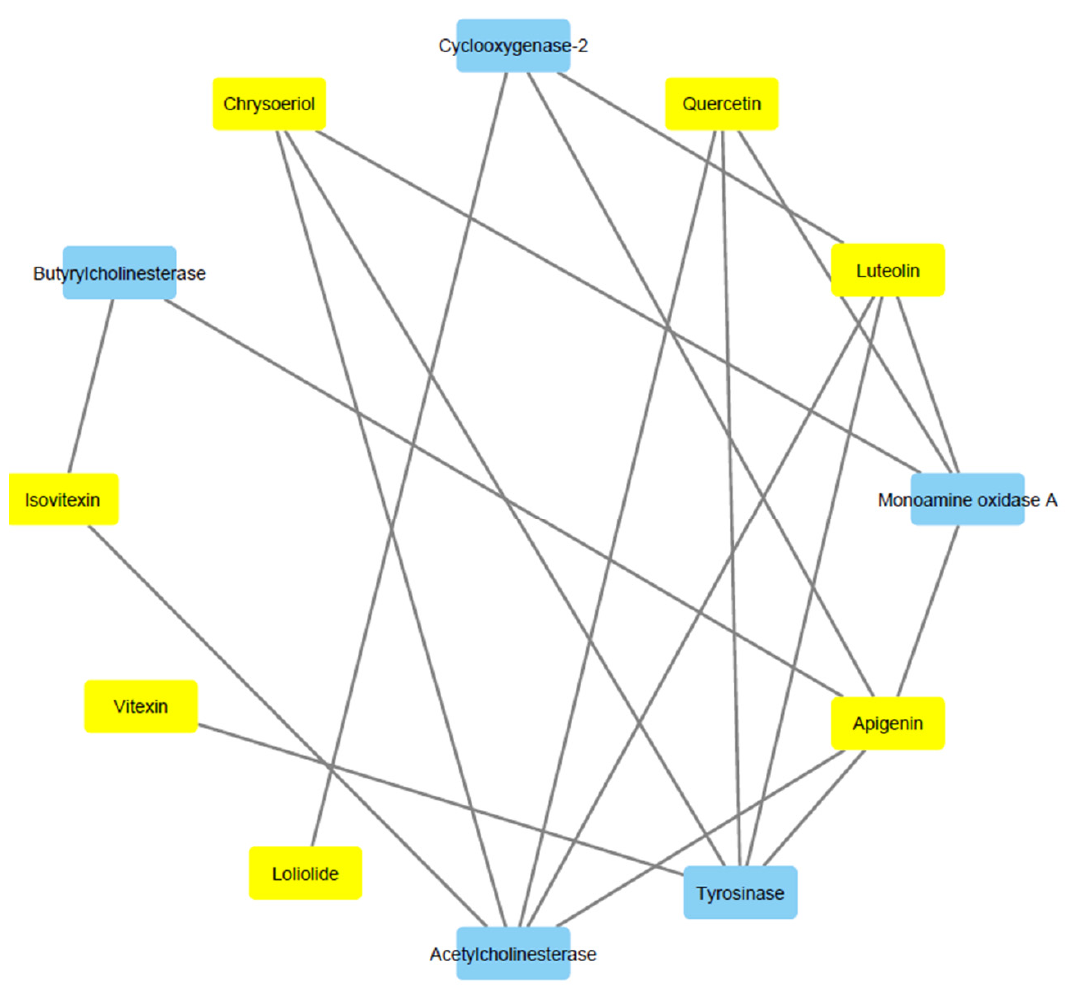
Figure 1. Components-Targets analysis.